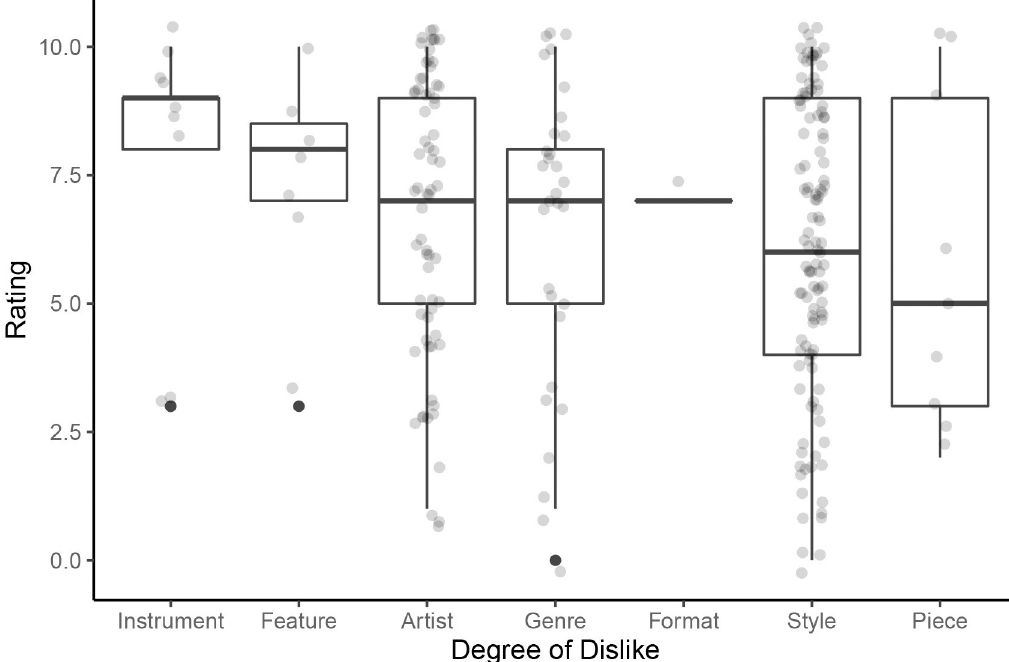
Fig 2. Dislike ratings per type. Participants rated their listed dislikes on an 11-point scale from 0 (neutral) to 10 (most severe dislike).